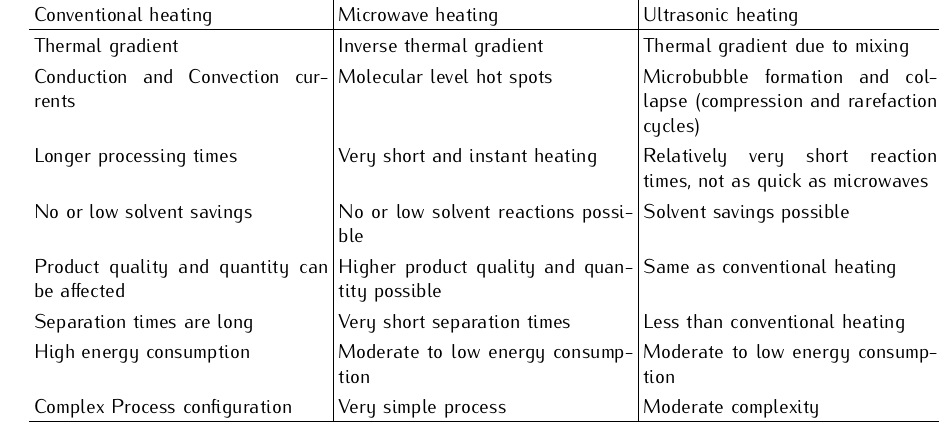
Table 1. Major advantages and disadvantages in different heating